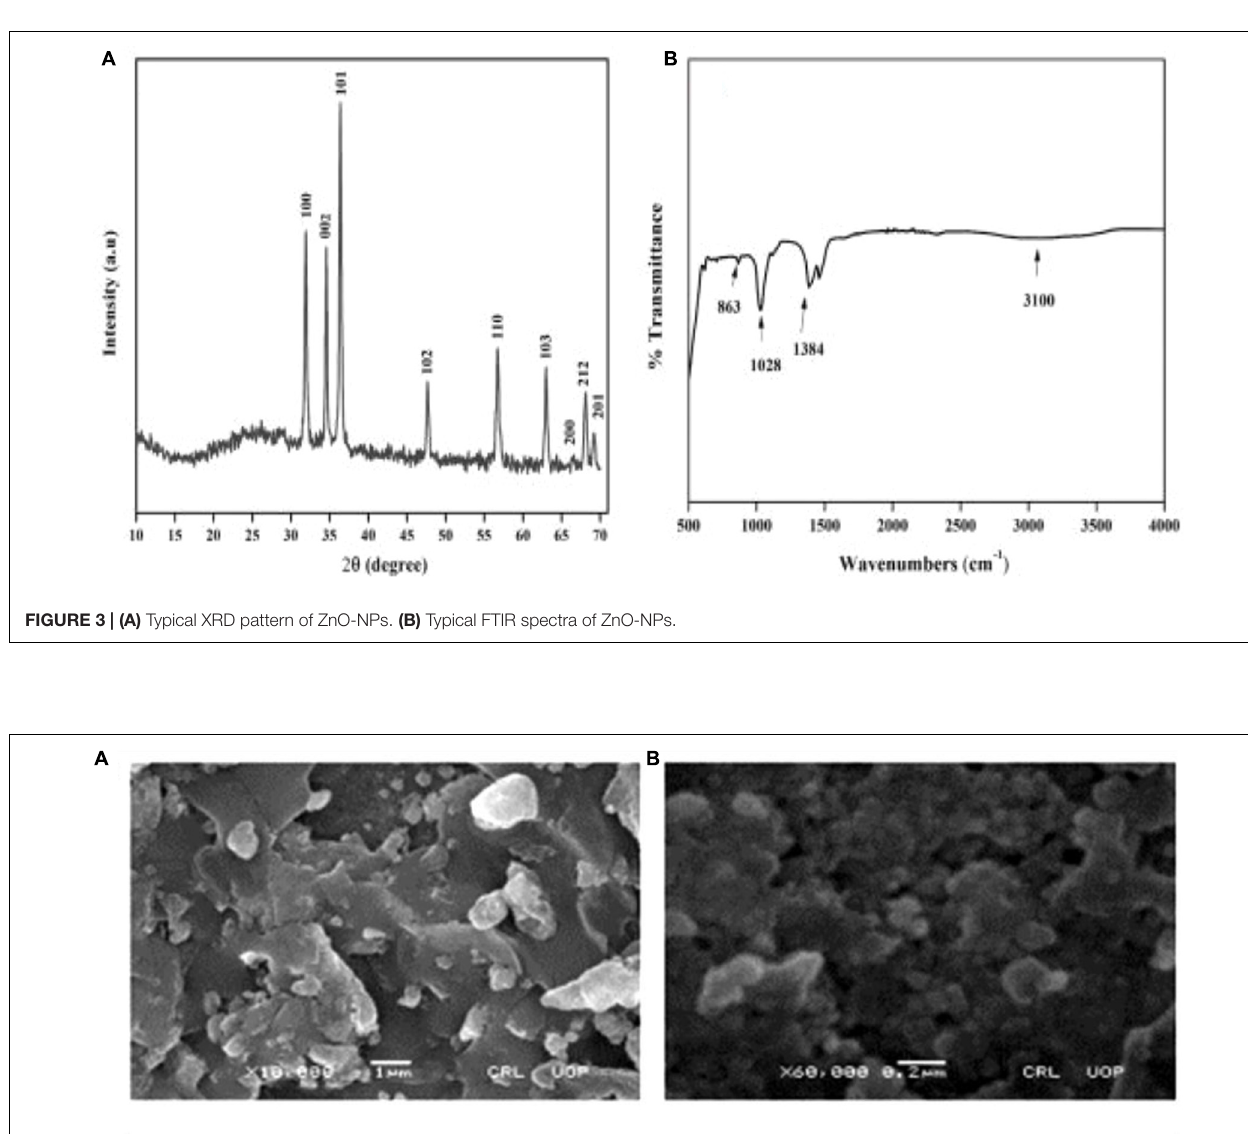
Frontiers in Materials |